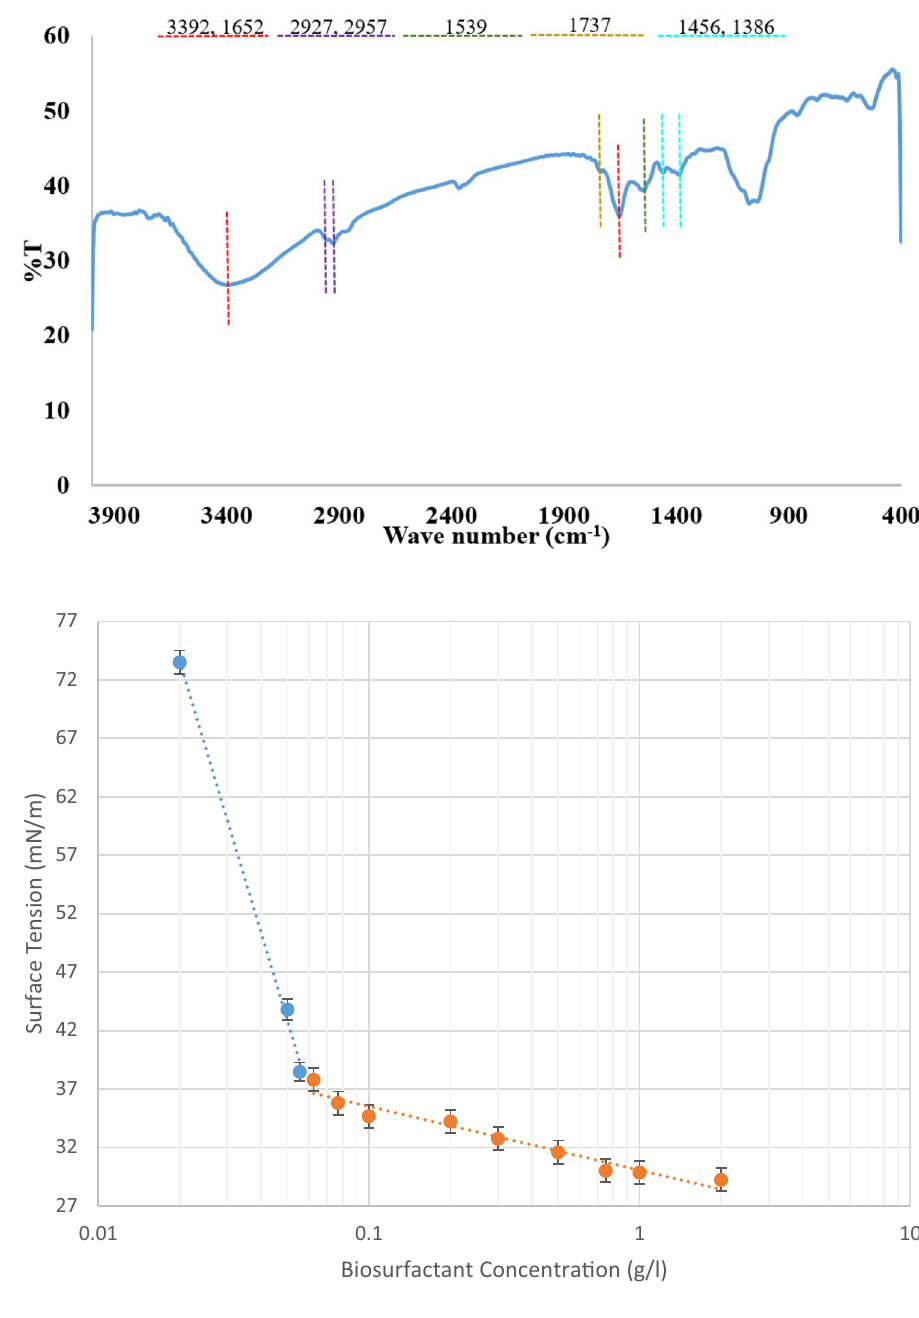
Fig. 2 FTIR spectra of bio- surfactant produced by MJ01 isolate